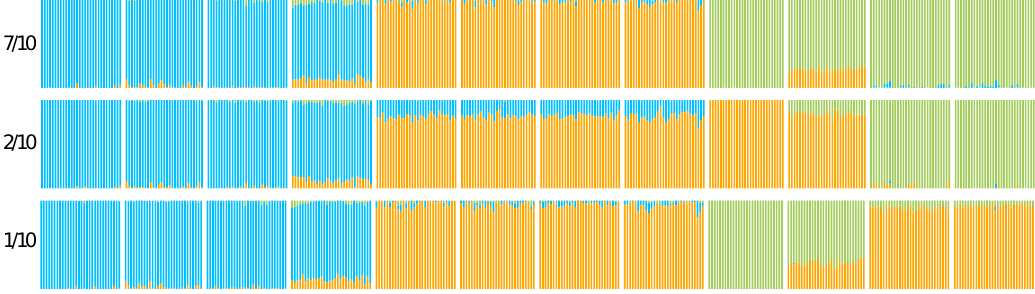
Figure S3. Results from Bayesian individual clustering with STRUCTURE for K = 3. The three figures correspond to major and minor modes detected.